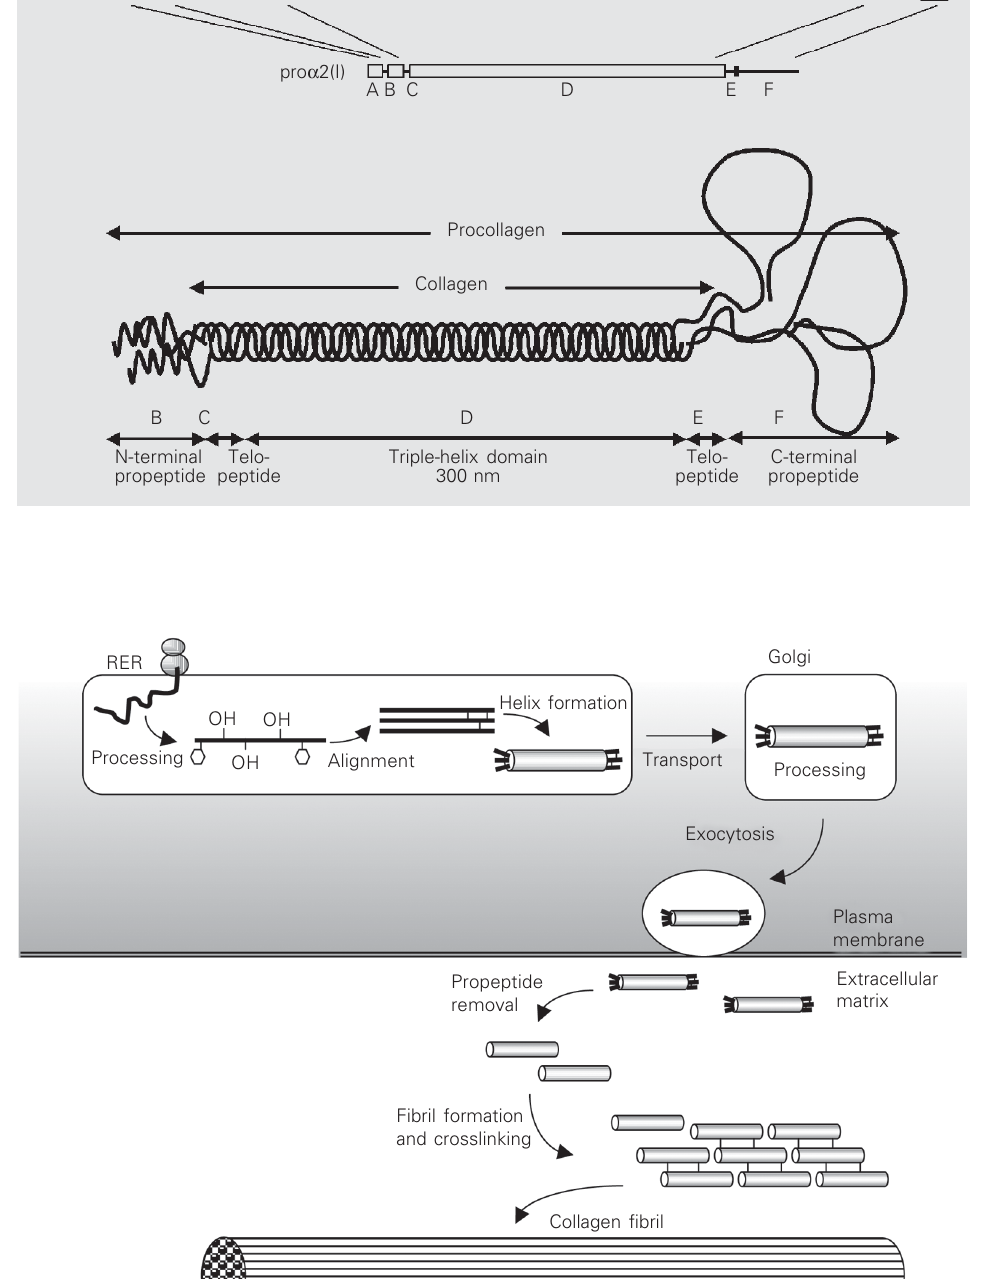
Figure 2. Genes that encode type I preprocollagen α chains (top) and domain structure of procollagen molecule (bottom). A , Signal sequence that is cleaved during rough endoplas- mic reticulum transit; B , N-ter- minal propeptide; C , short non- triple-helix domain that contains the site of proteolytic cleavage of N-terminal peptides; D , major triple-helix domain, character- ized by the Gly-X-Y repeats; E , telopeptide; F , N-terminal pro- peptides that contain disulfide